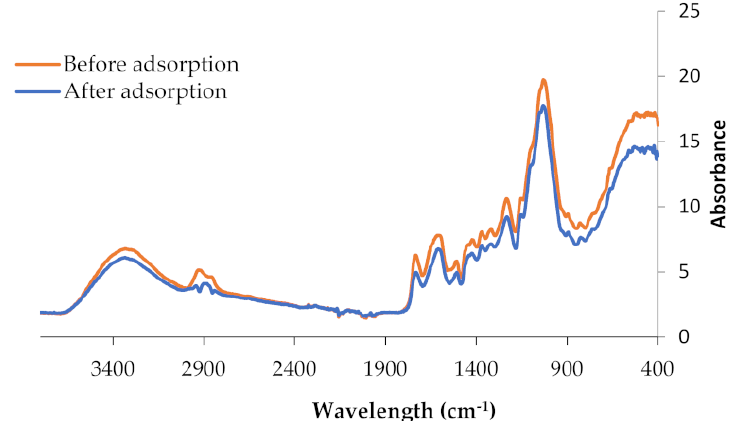
Figure 2. Characterization of walnut shell by FTIR-ATR analysis.